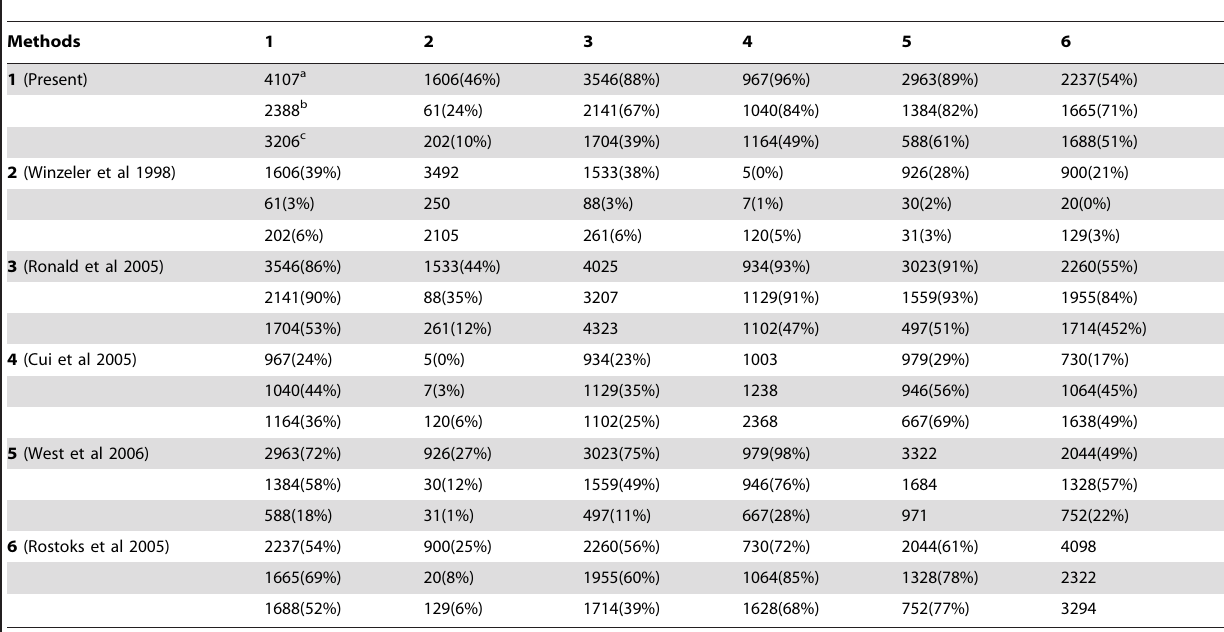
Table 3. Comparison in SFP predictability between methods 1–6 from the three datasets.